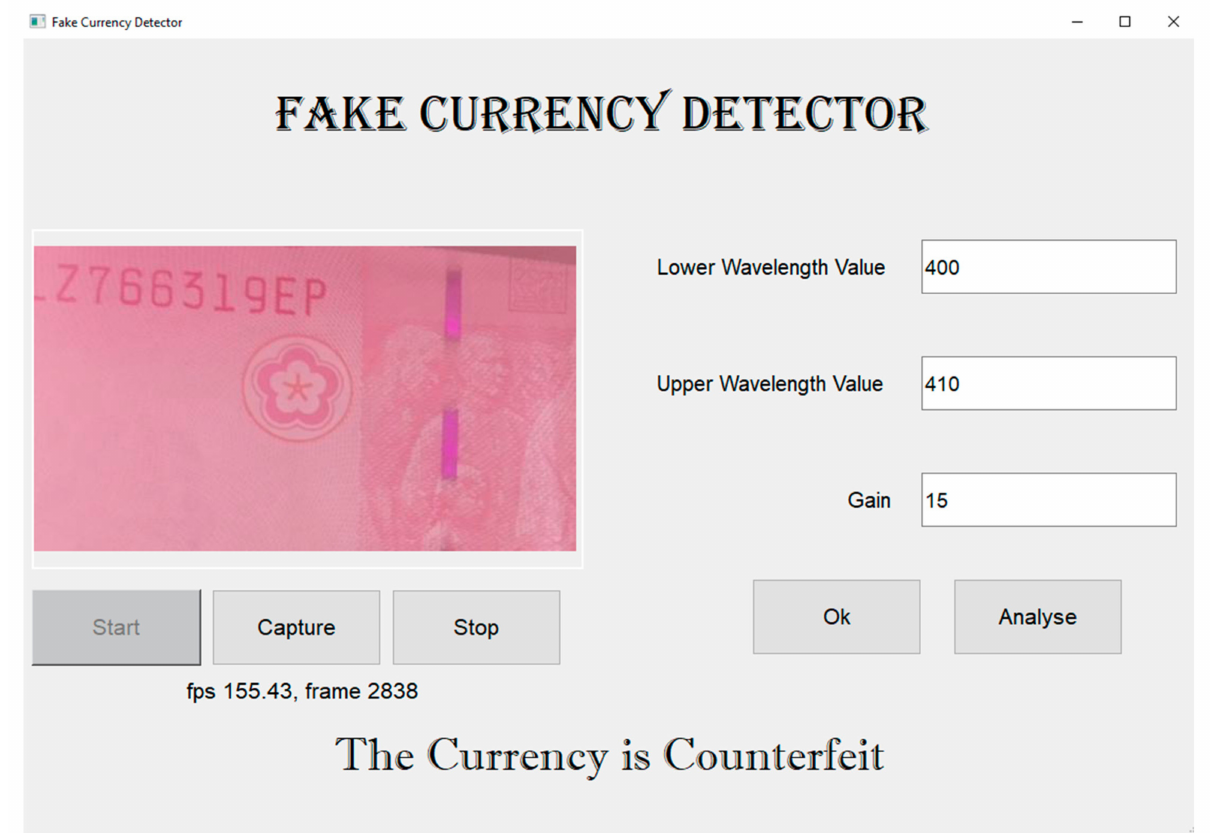
Figure 8. Python-based Windows application for detecting counterfeit